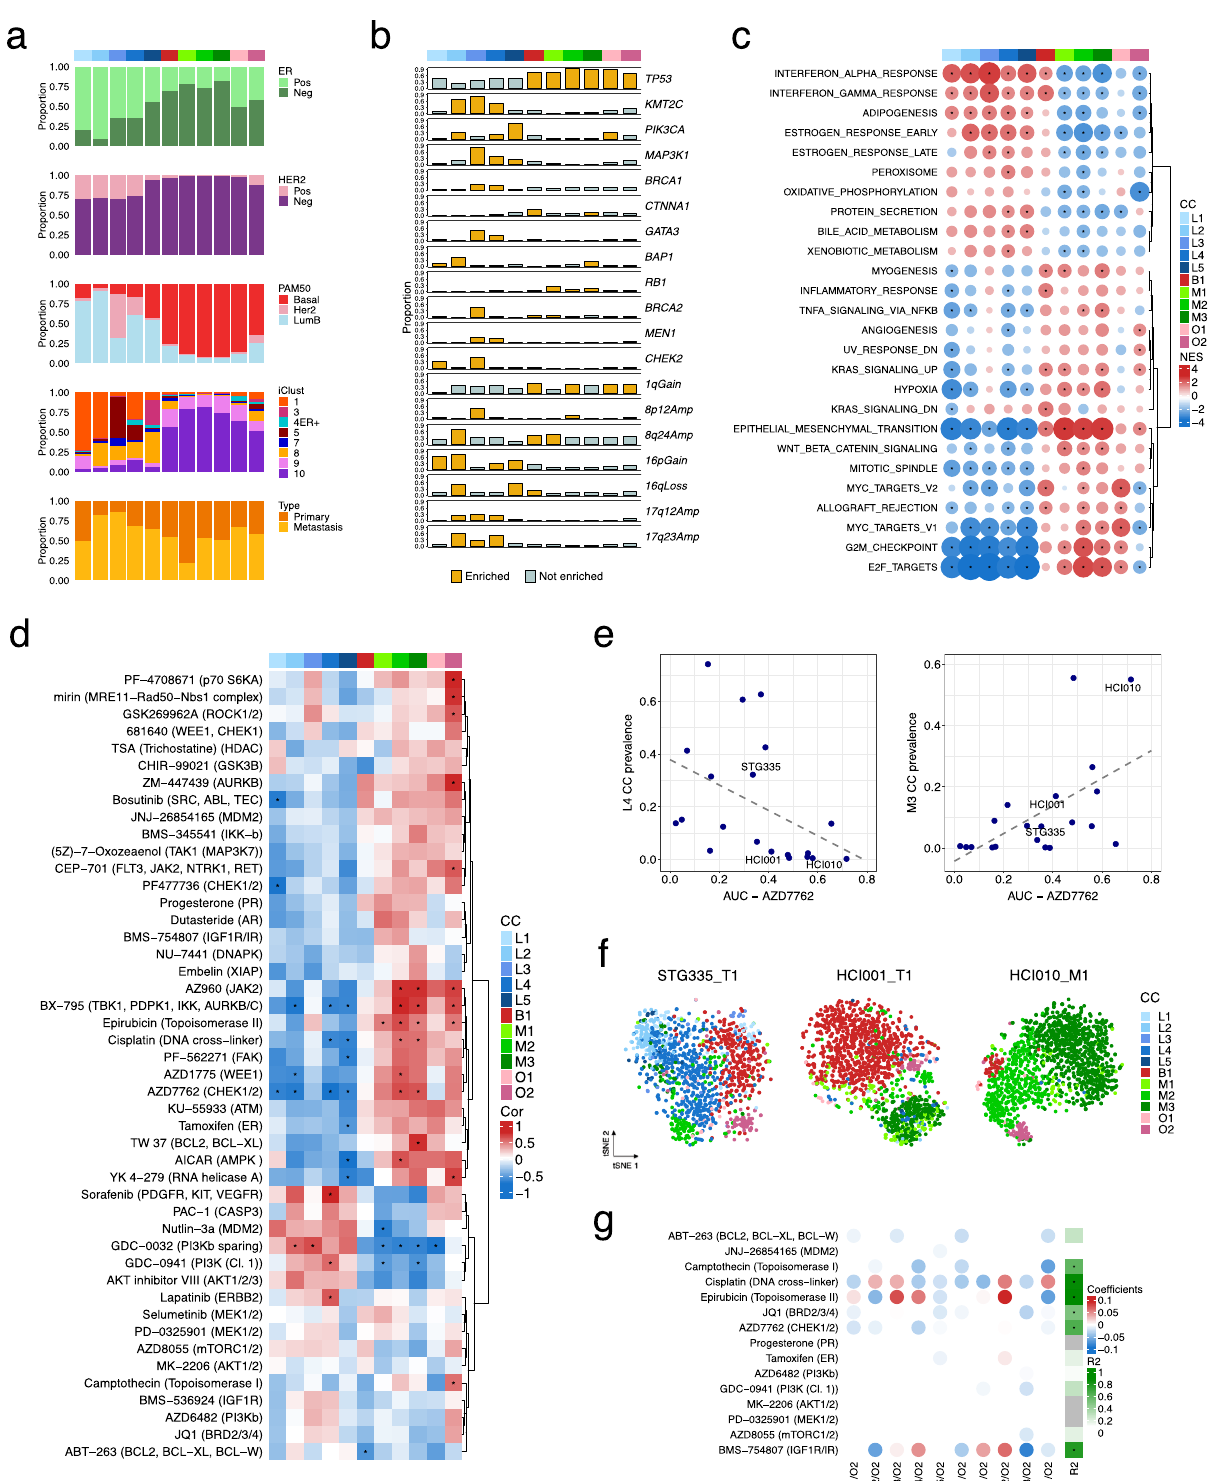
from intClust 1 PDTXs were mostly L1/L2 and to a lesser